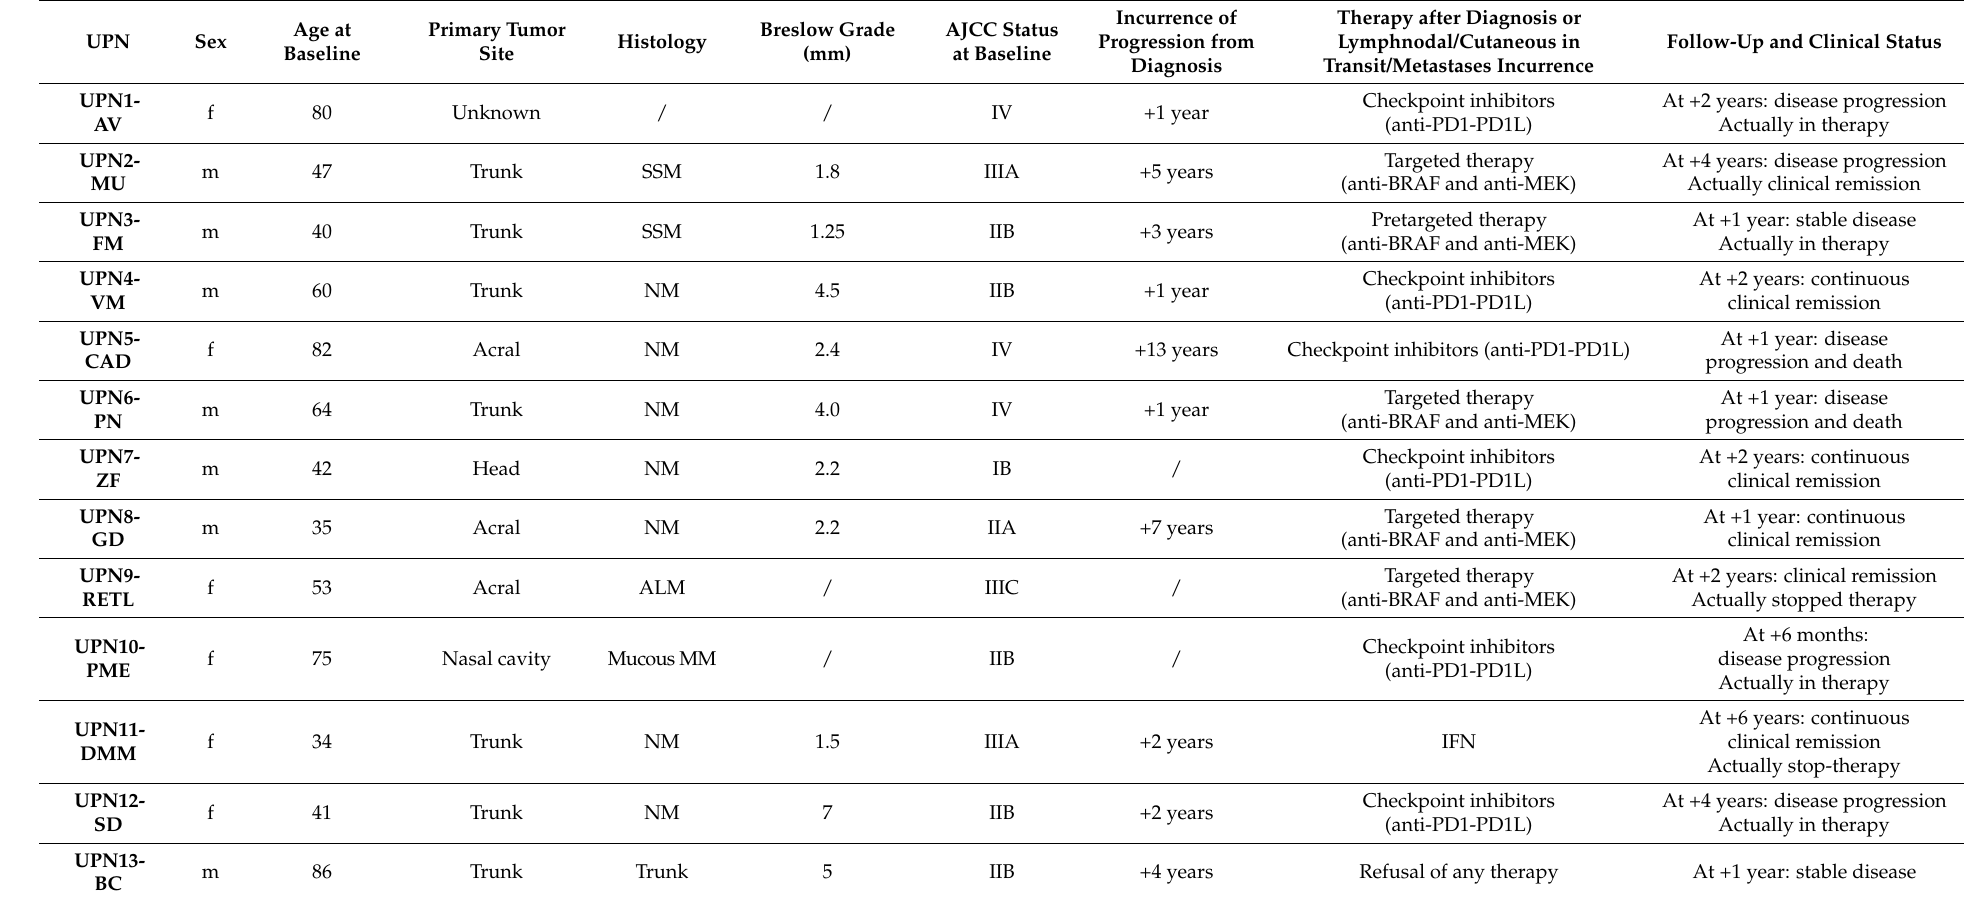
Table 3. Patients’ demographic and histological characteristics, and clinical